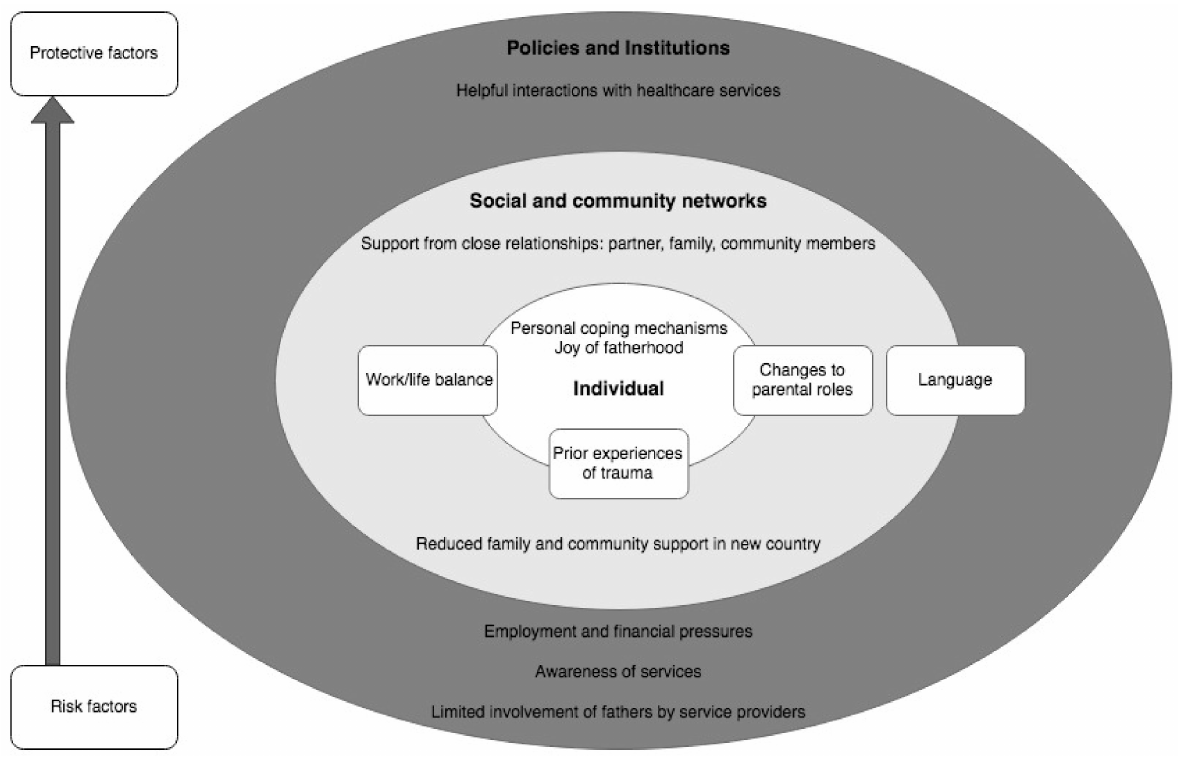
Figure 1. Socioecological map of identified